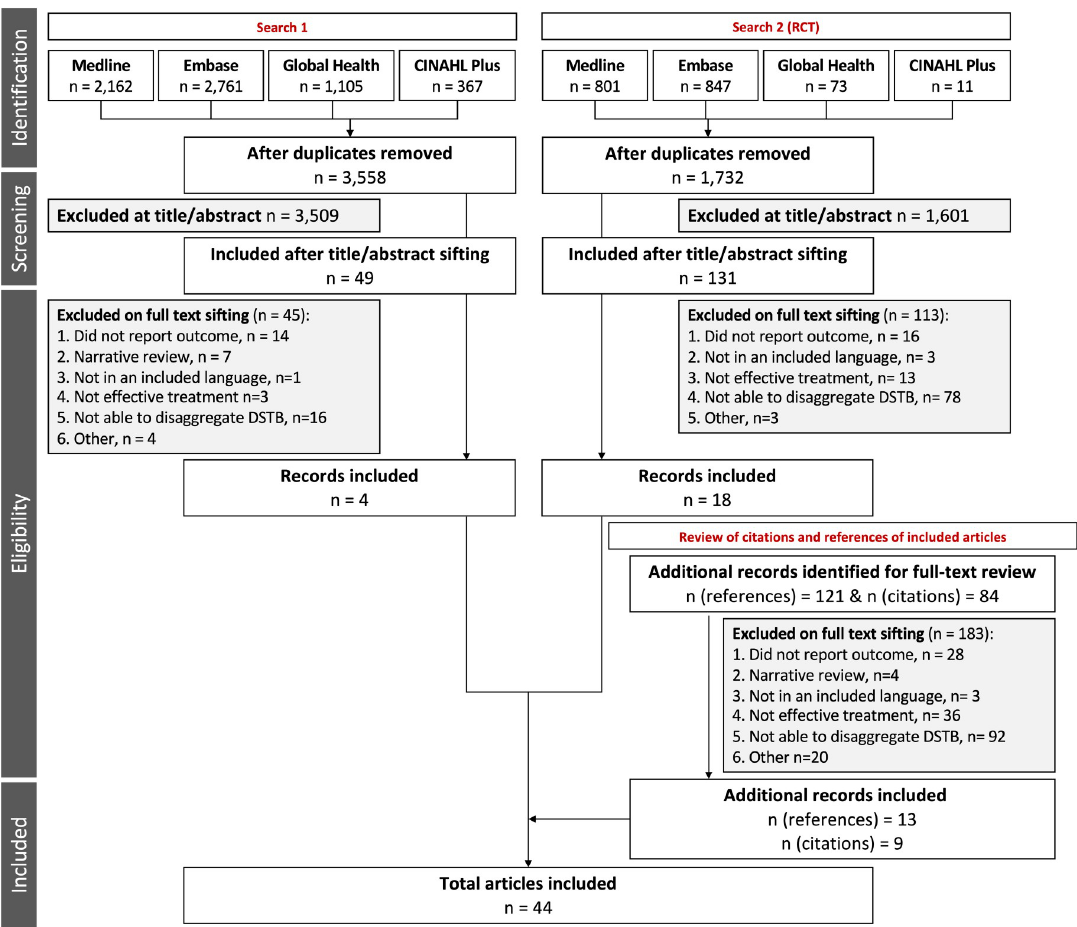
Fig 1. Flow diagram showing databases searched and process for article inclusion. AU : ThereisanasteriskintheAdditionalrecordsincludedboxinFig 1 ; butnocorrespondingfootnoteinthelegendforFig 1 : Pleaseeither ð 1 Þ deletetheasteriskor ð 2 Þ providethemissingfootnoteinformationinthefigurelegend : Two searches were developed, conducted by a professional librarian: a primary search and a second search that aimed to identify all RCTs of tuberculosis treatment conducted since 1990, as described in text. DSTB, drug-susceptible tuberculosis; n, number of studies; RCT, randomised controlled trial.